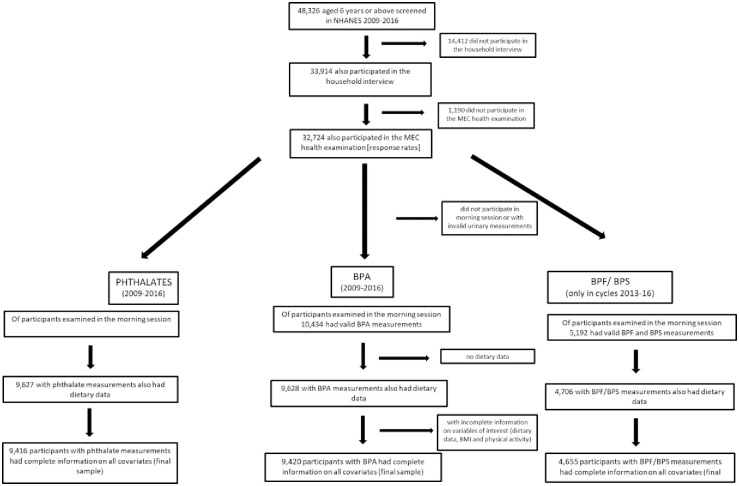
Study flowchart.